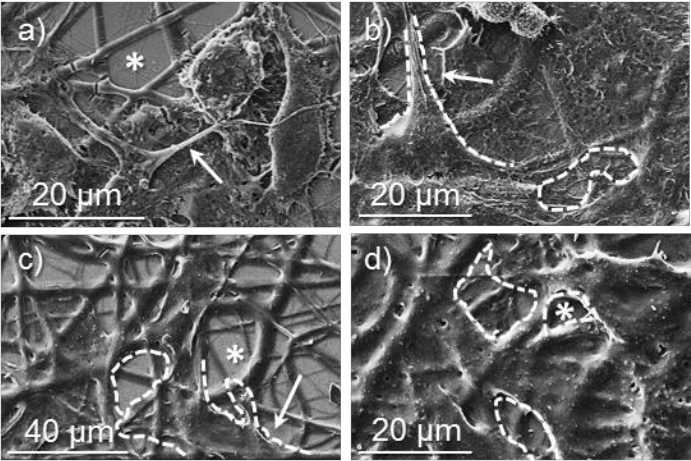
Figure 14. SEM micrographs showing cellular adhesion and proliferation on surfaces of poly(glc-6-glc 6) electrospun scaffolds: ( a ) COS-7 cell adhesion on an unloaded sample; ( b ) COS-7 cell proliferation on a sample loaded from 5% KTP containing electrospun solution; ( c ) VERO cell adhesion on an unloaded sample; ( d ) VERO cell proliferation on an unloaded samples. Dashed lines highlight cell